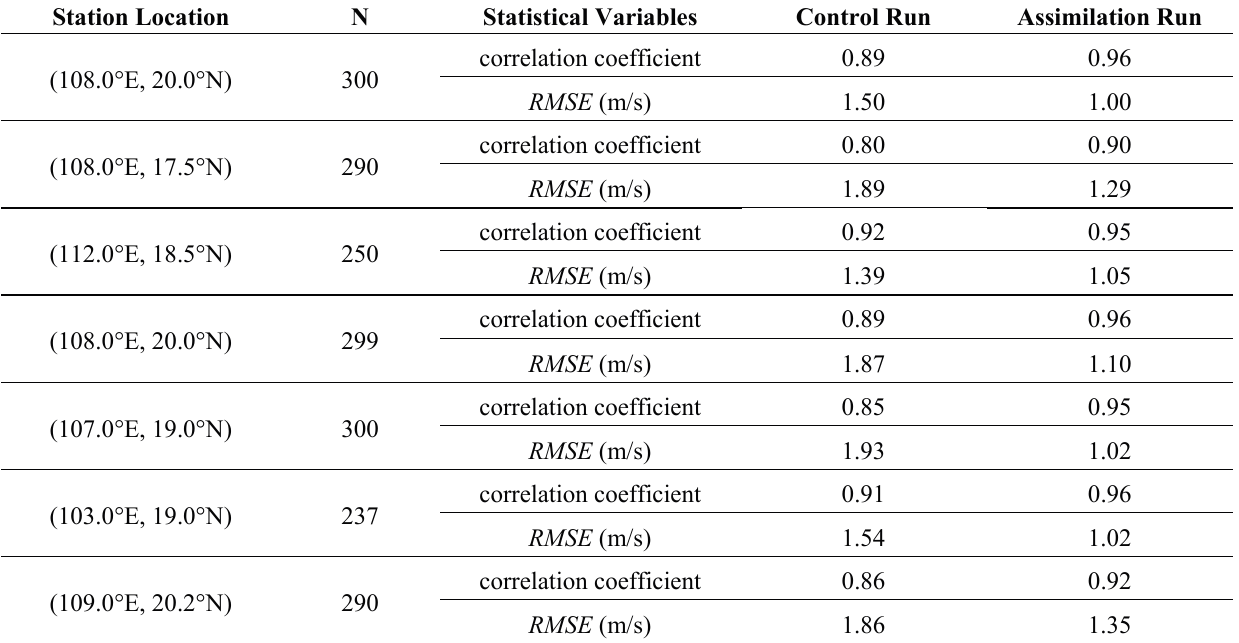
Table 8. Validation of the control run and assimilation run with in situ measurements . N S and N A are the co-located samples for SAR and ASCAT, RMSE ct (m/s) and RMSE da (m/s) are the root mean square error for control runs and assimilation runs during 2011, Δ RMSE (m/s) is the difference between RMSE da and RMSE ct . Station